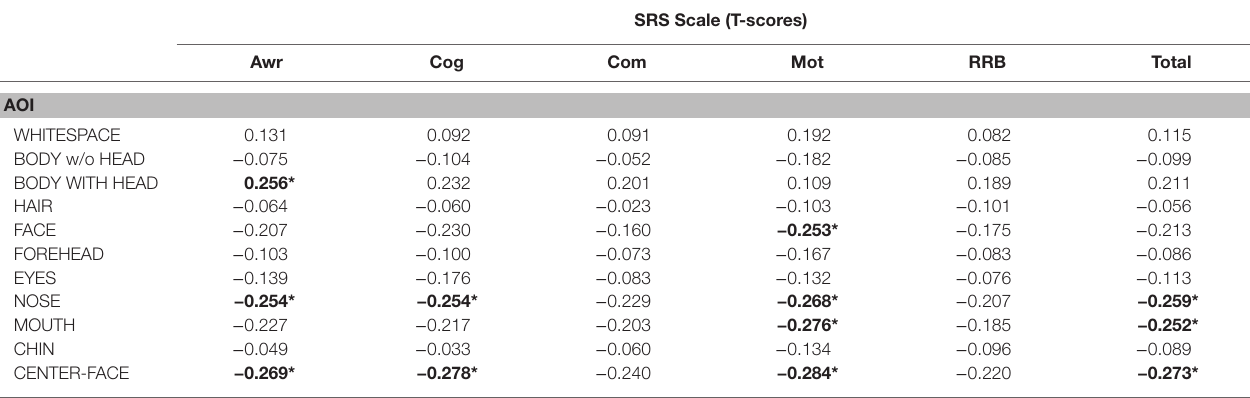
TABLE 3 | Intercorrelations of AOI-based measures and SRS scales.